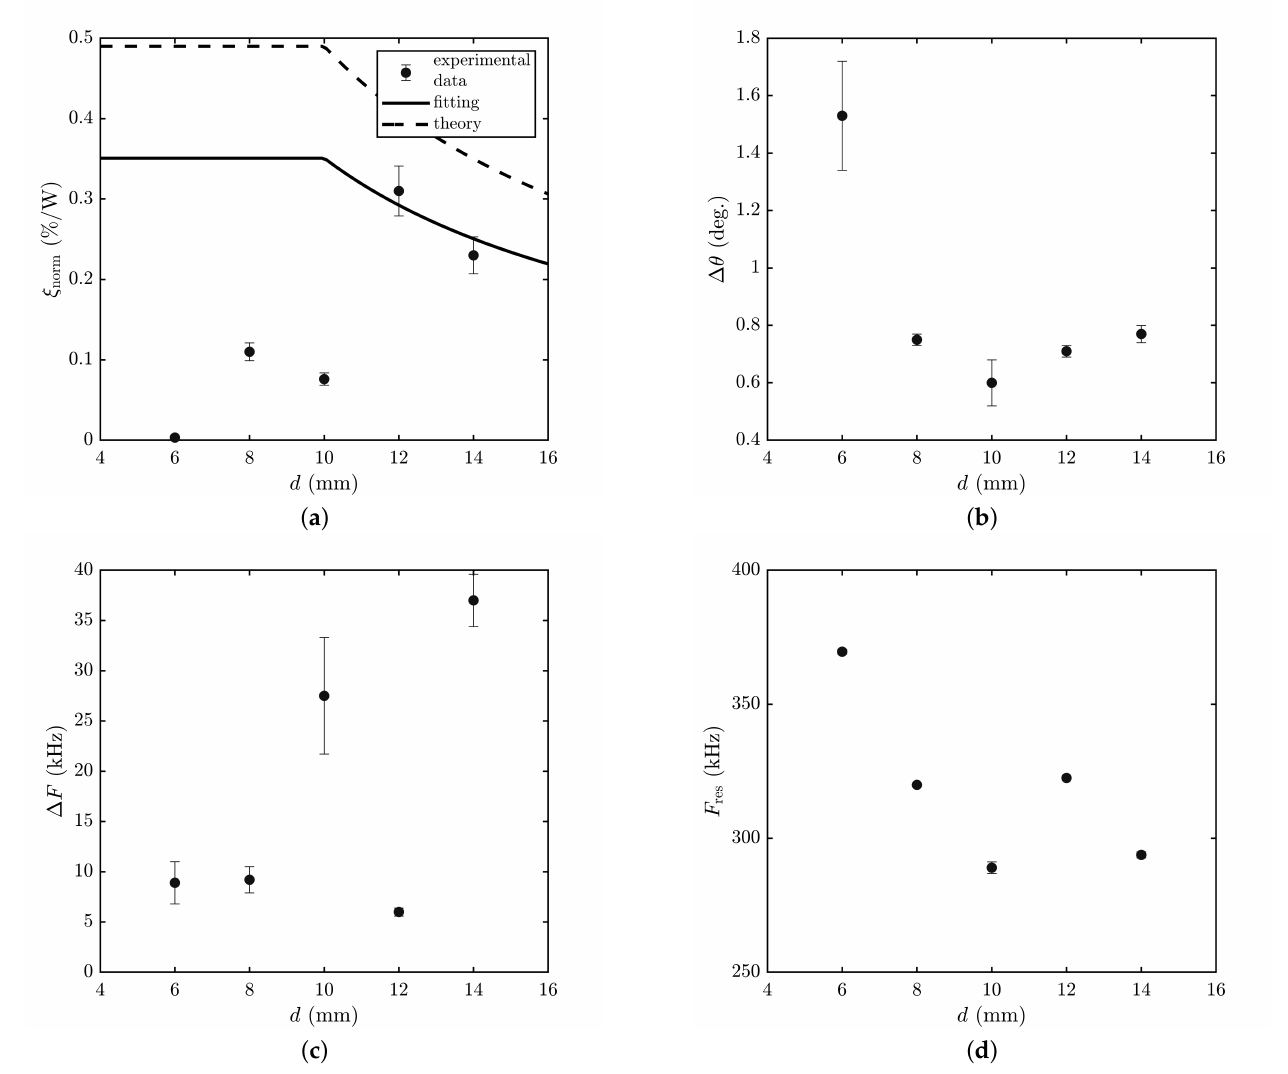
Figure 6. Dependence of parameters of AO modulator on width d of ultrasound transducer: ( a ) AO diffraction efficiency per 1 W of input electric power; ( b ) angular bandwidth; ( c ) frequency bandwidth; ( d ) operating